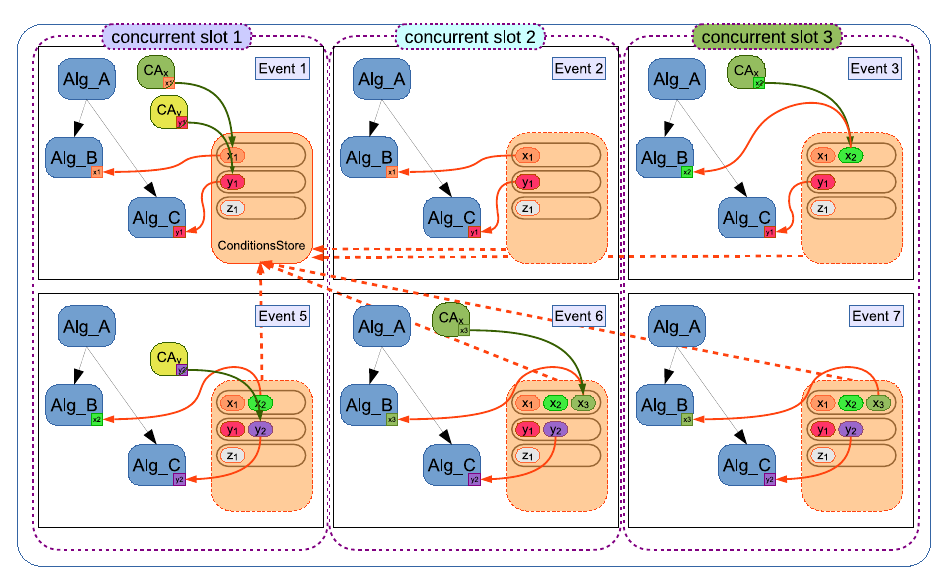
Figure 1. The ATLAS multi-cache Conditions